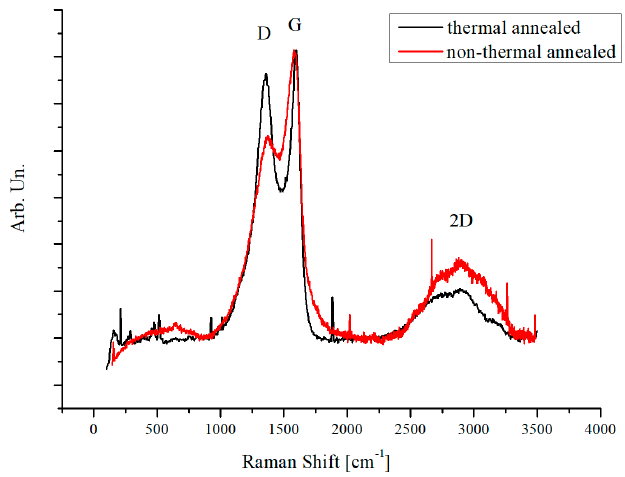
Figure 4. Raman spectra of thermally treated and non-thermally treated biochar.